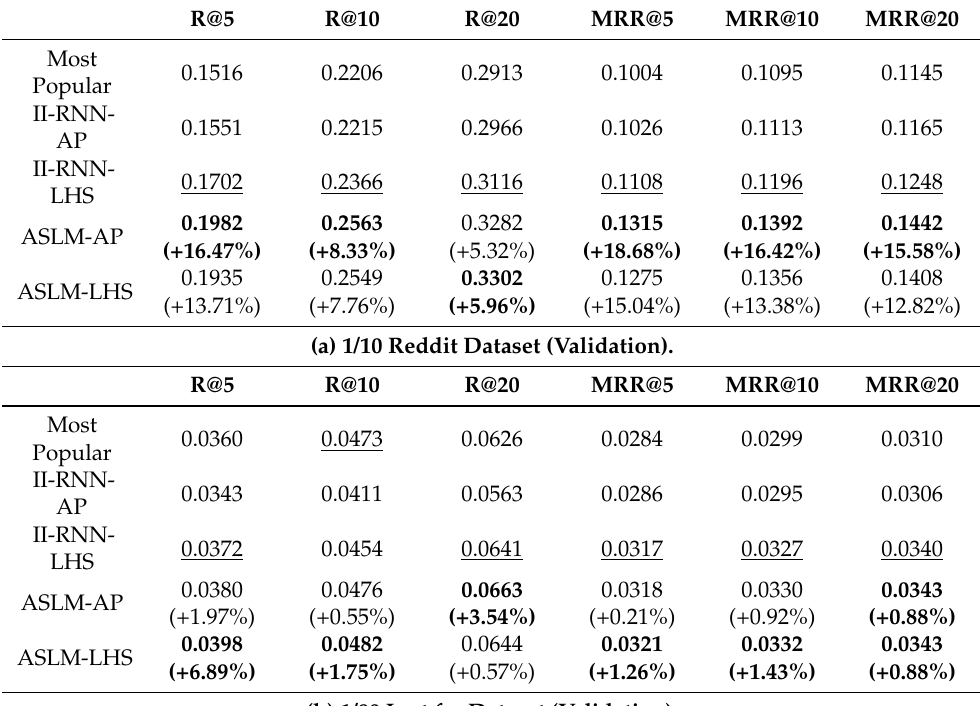
Table 5. Group B: Recall and MRR scores for the ASLM models and the baselines for the validation sets in 1/10 Reddit and 1/80 Last.fm